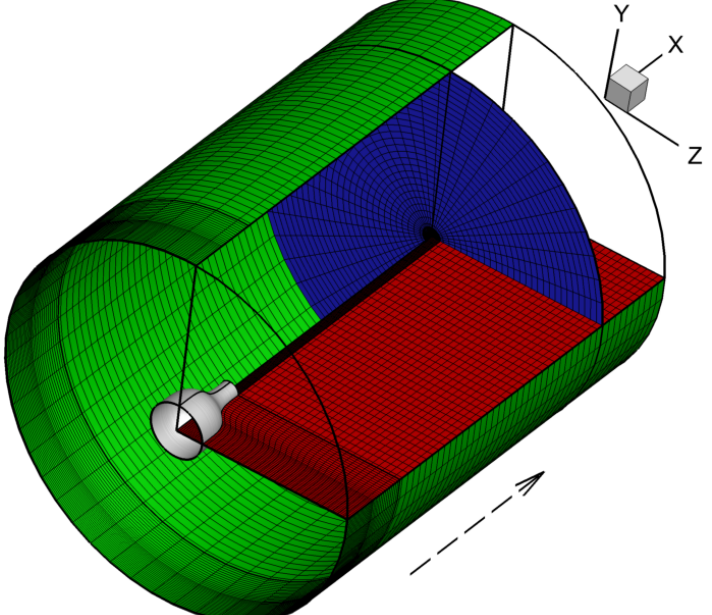
Figure 1. Computational grid used for the LES. The nozzle is shown on the left using the gray surface. The azimuthal (red), axial (blue) and radial (green) surfaces are also marked to display the grid lines. Every tenth axial and radial point, and every other azimuthal point is marked on these surfaces. The dotted arrow indicate the jet-flow